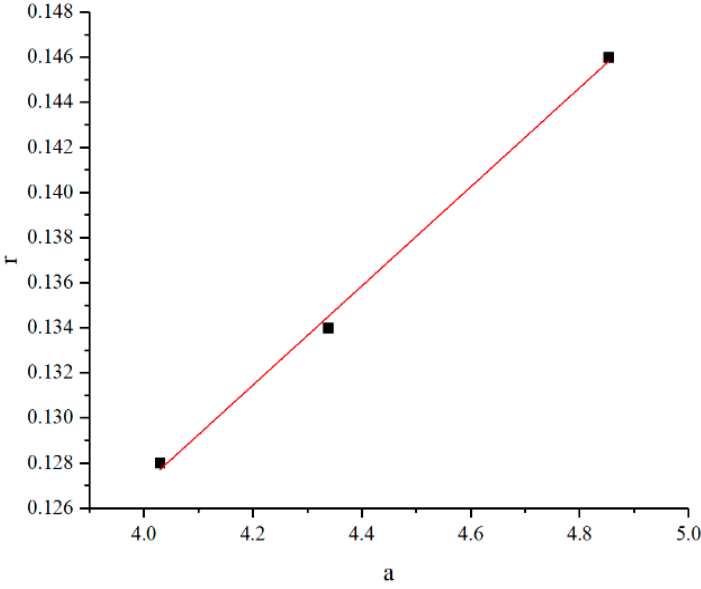
Figure 14. Relationship between parameter a and parameter r.